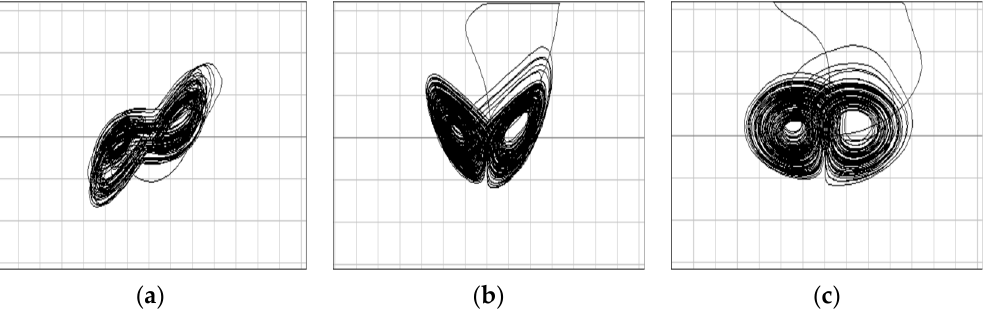
Figure 13. Circuit simulation diagram. ( a ) x-y plane; ( b ) x-z plane; ( c ) y-z